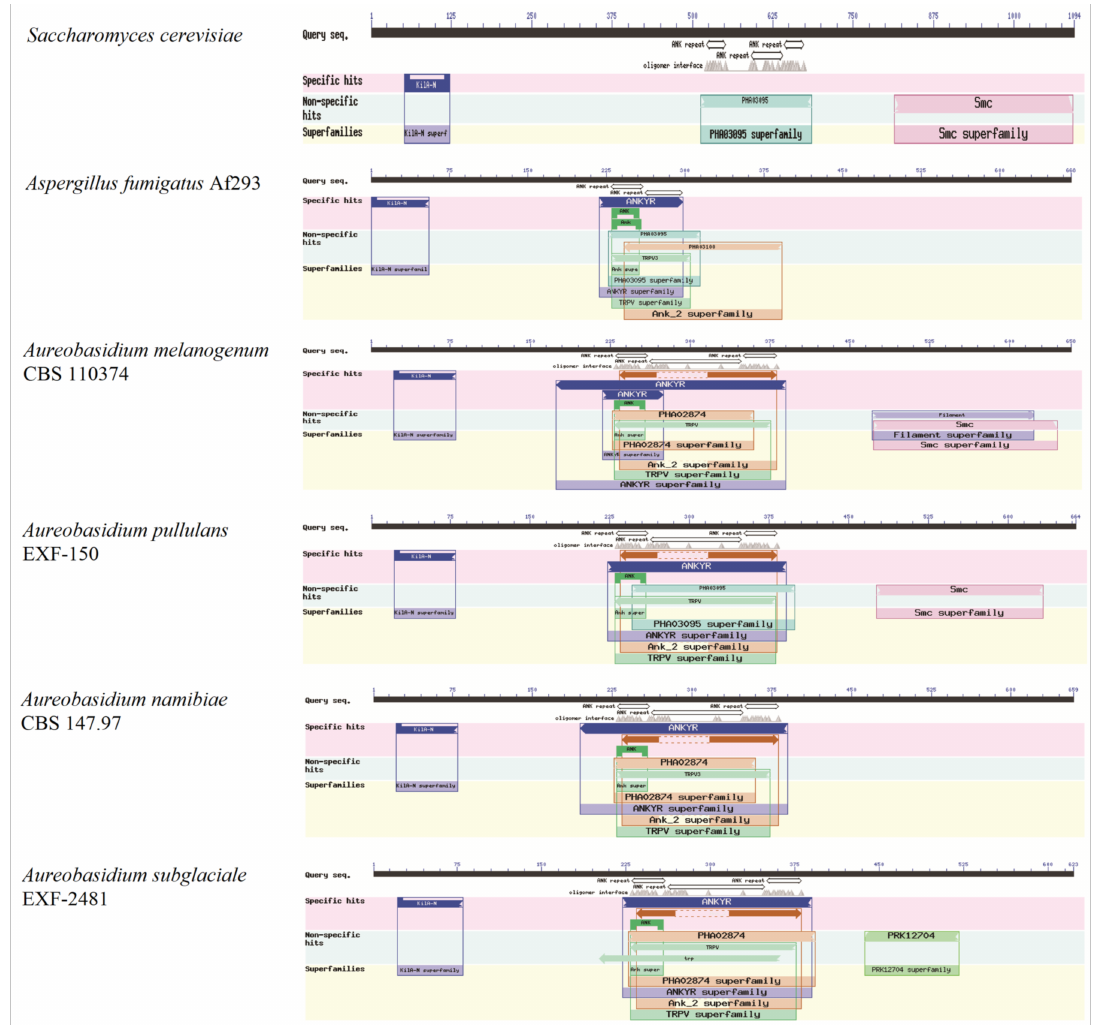
Figure 3. Conserved functional domains of the KilA-N type protein